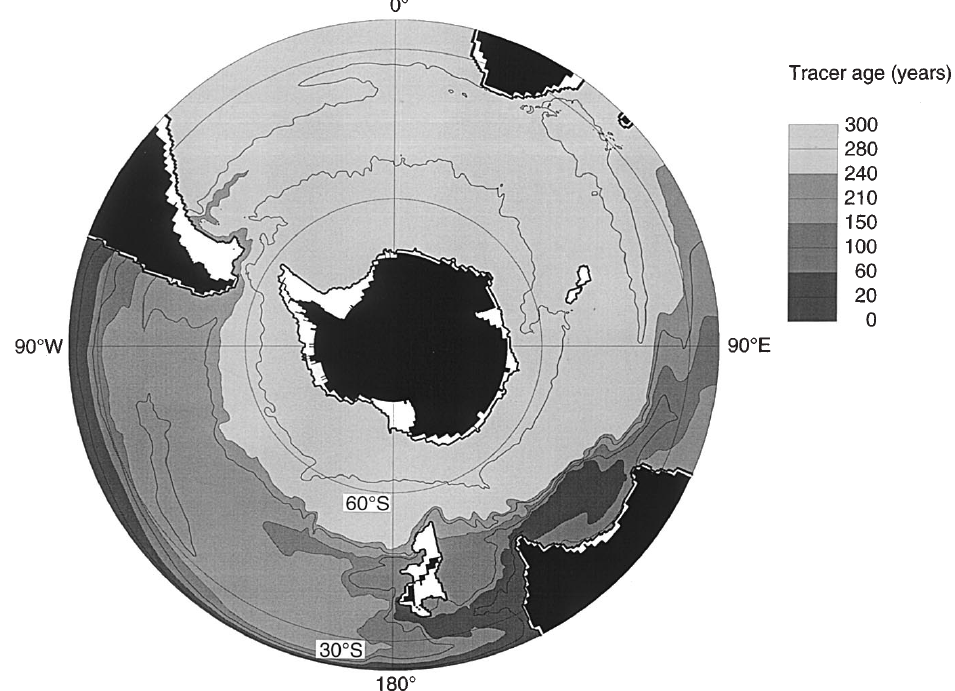
Fig. 4. A horizontal section at 1087 m illustrating the age